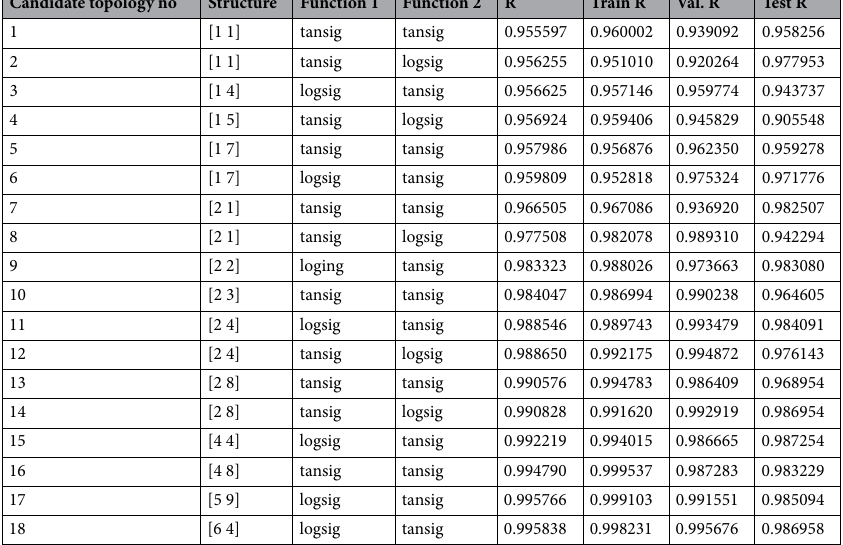
Table 1. Characteristics of top 18 ANN